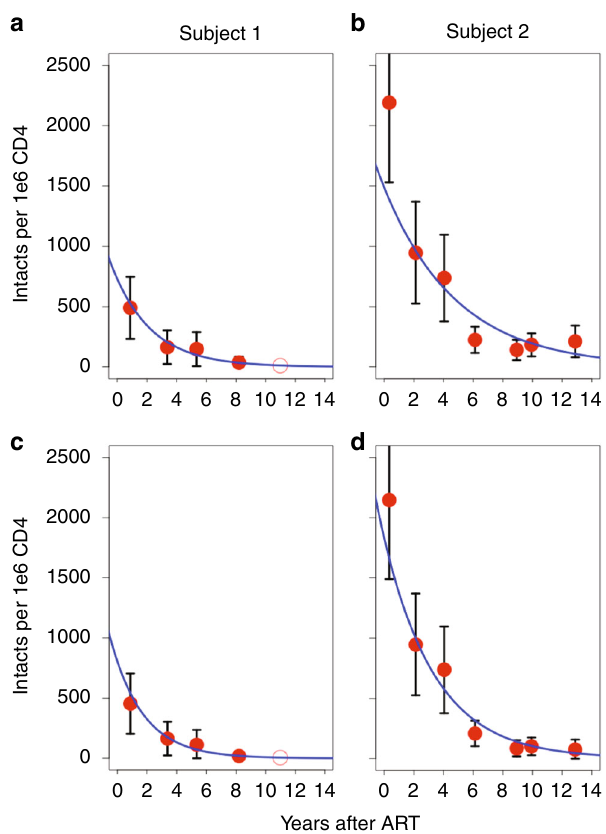
Fig. 2 Dynamic changes of intact proviruses over time. a Frequency of intact proviruses after initiating treatment for Subject 1 measured by intact copies per million CD4 T cells. Red circles represent intact proviruses calculated by multiplying the concentration of total HIV DNA per CD4 by the frequency of sequenced proviruses that were intact. b Frequency of intact proviruses for Subject 2. c Frequency of intact proviruses for Subject 1 when counting clones only the fi rst time they were detected in order to minimize the effects of clonal expansion. d Frequency of intact proviruses in Subject 2 with clones counted only once, when they fi rst appeared. We included fi ve time points for Subject 1 and 7 for Subject 2. For Subject 1, we did not identify any intact provirus in 2018, and therefore this time point is presented as an open circle. Black bars signify 95 percent con fi dence interval of the mean based on a binomial process with approximately 100 sequences per time point. The blue line is the estimated decay based on a exponential decay model